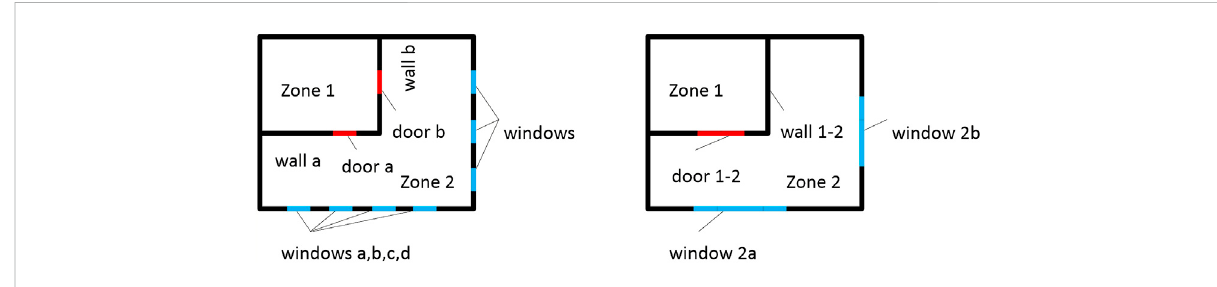
FIGURE 10 Number of elements in model: (left) detailed elements, (right) aggregated